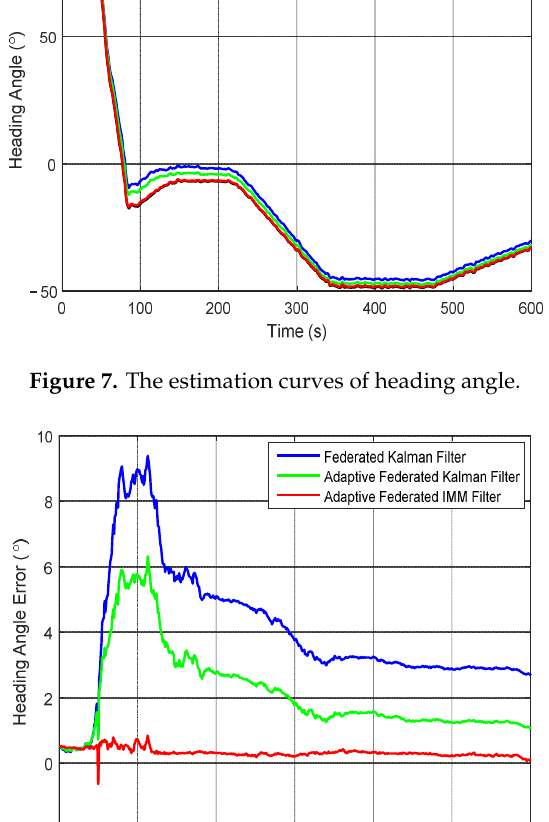
Figure 7. The estimation curves of heading angle.